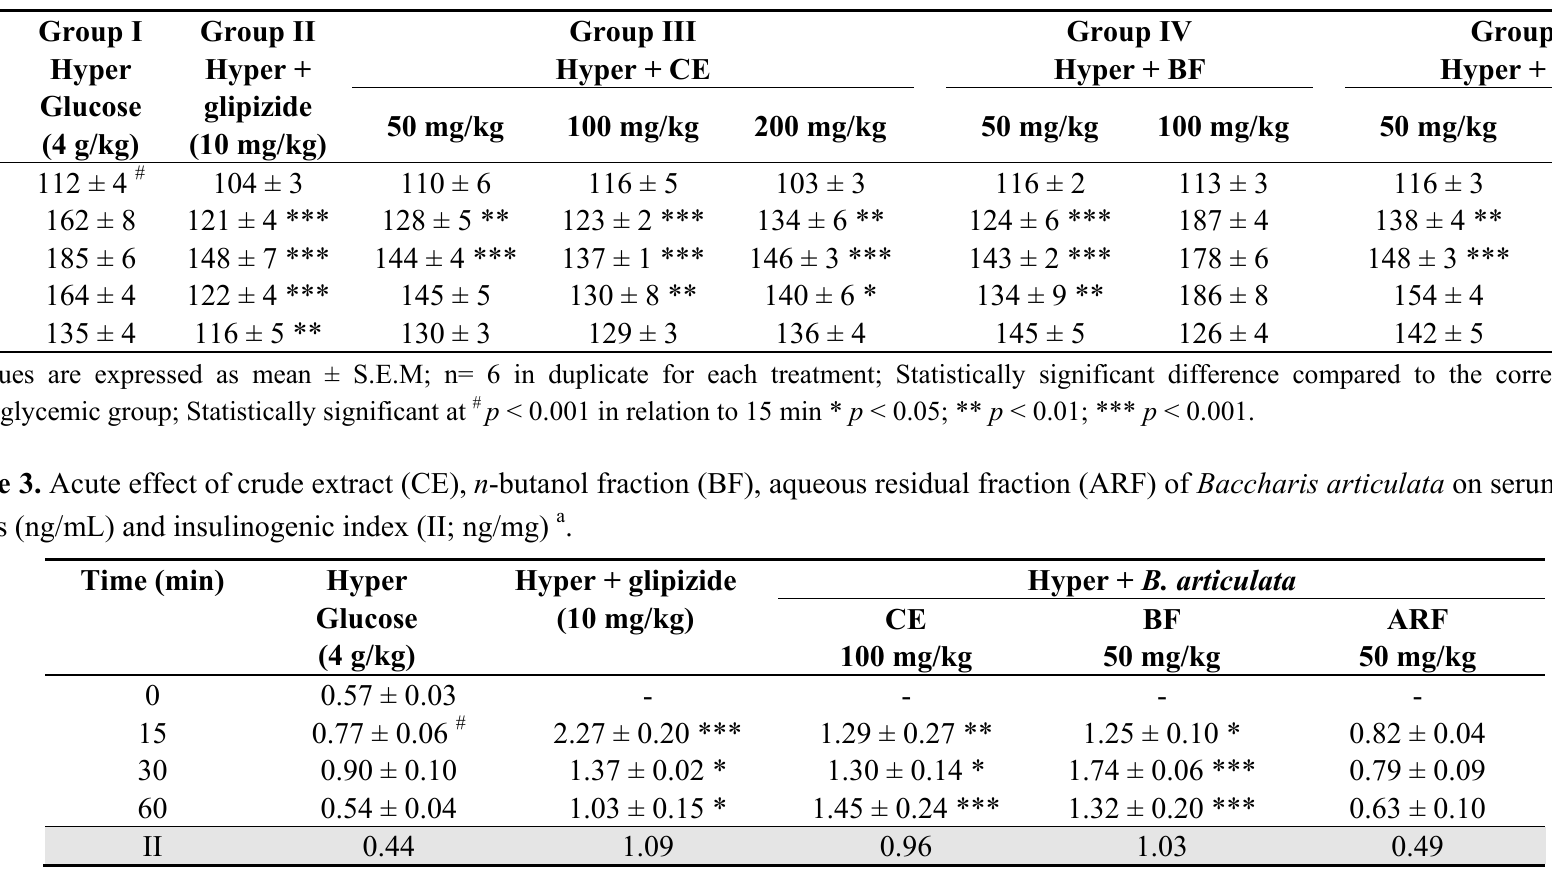
Table 2. Acute effect of crude extract (CE), n -butanol fraction (BF) and aqueous residual fraction (ARF) of Baccharis articulata on serum glucose levels (mg/dL) in oral glucose tolerance curve a .